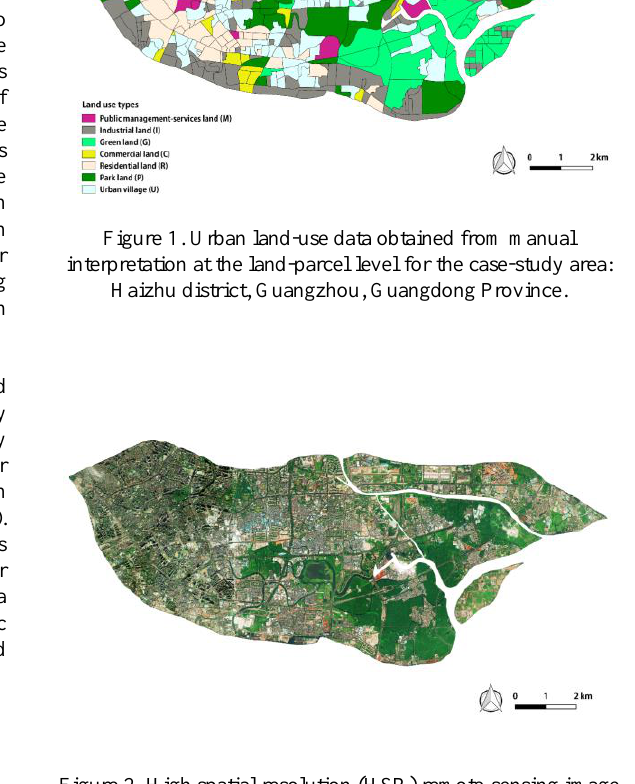
Figure 2. High spatial resolution (HSR) remote-sensing image of the study area provided by Worldview-2